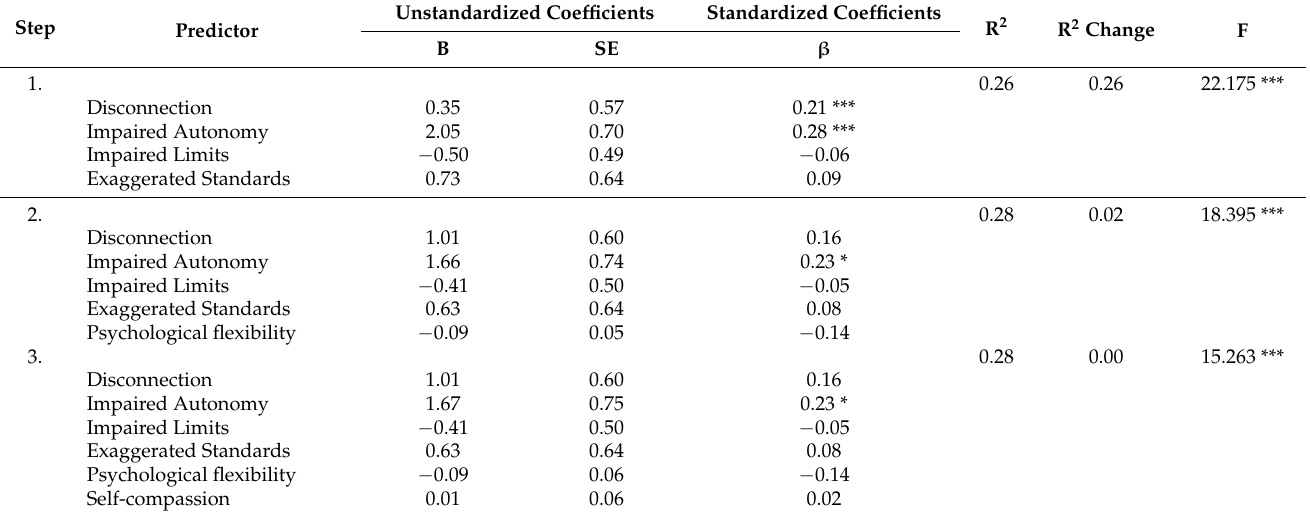
Table 4. Hierarchical regression analyses, * p < 0.05, *** p < 0.001.